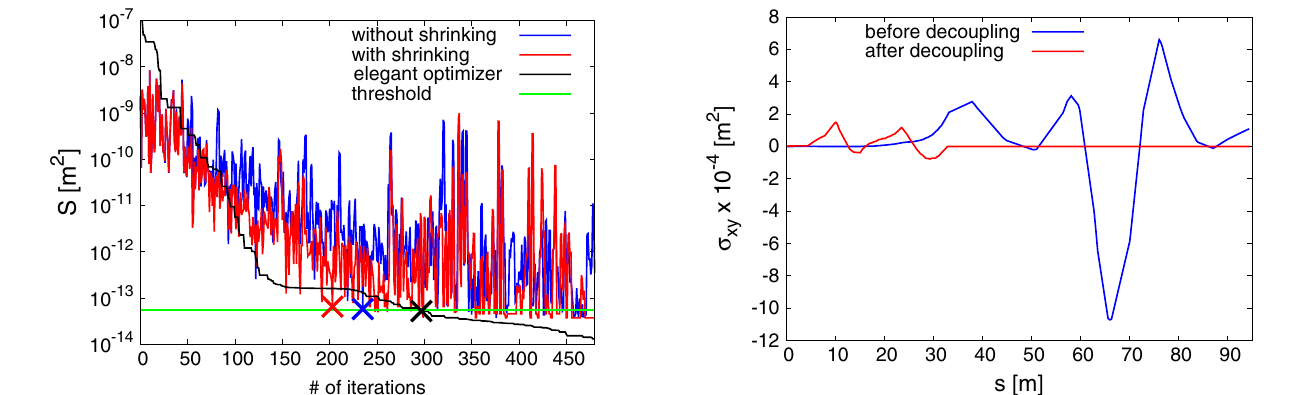
FIG. 16. (cid:6) xy correlations at the end of the injector line before and after the decoupling procedure. Not shown are the other off- diagonal terms that are nulled as well.